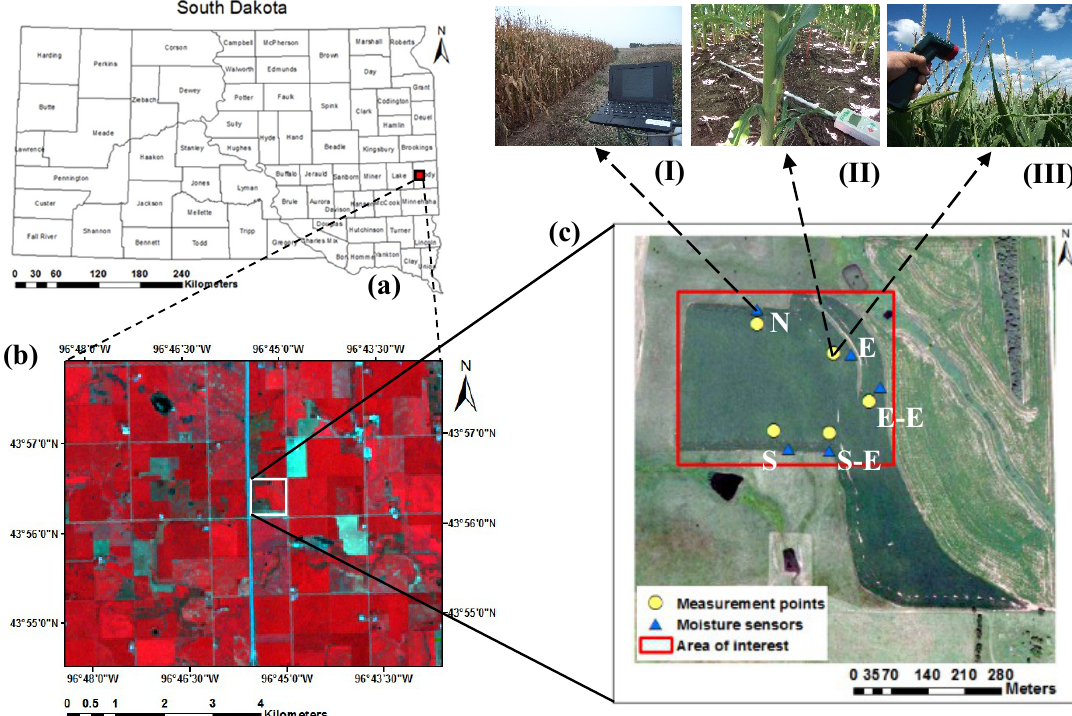
Figure 1. ( a ) South Dakota with county boundaries, the red rectangle shows the study area in eastern South Dakota. ( b ) Landsat 8 with false color composite (bands 5, 4, 3), the white rectangle indicates the experimental corn field. ( c ) The aerial photo with area of interest (red rectangle) shows measurement points (yellow circles) and moisture sensors (blue triangles) at the five observation locations (N, S, S-E, E, and E-E). Pictures I, II, and III show the collection of soil moisture data, LAI, and Ts, respectively. Table 1. Observation locations, altitude, soil texture, field capacity (FC), and permanent wilting point (PWP).